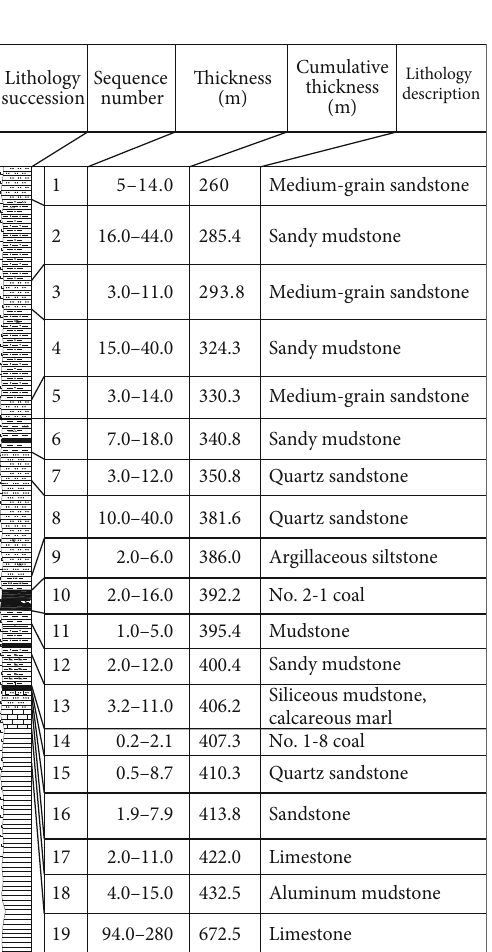
Figure 1: Stress state of the elements in coal seam.